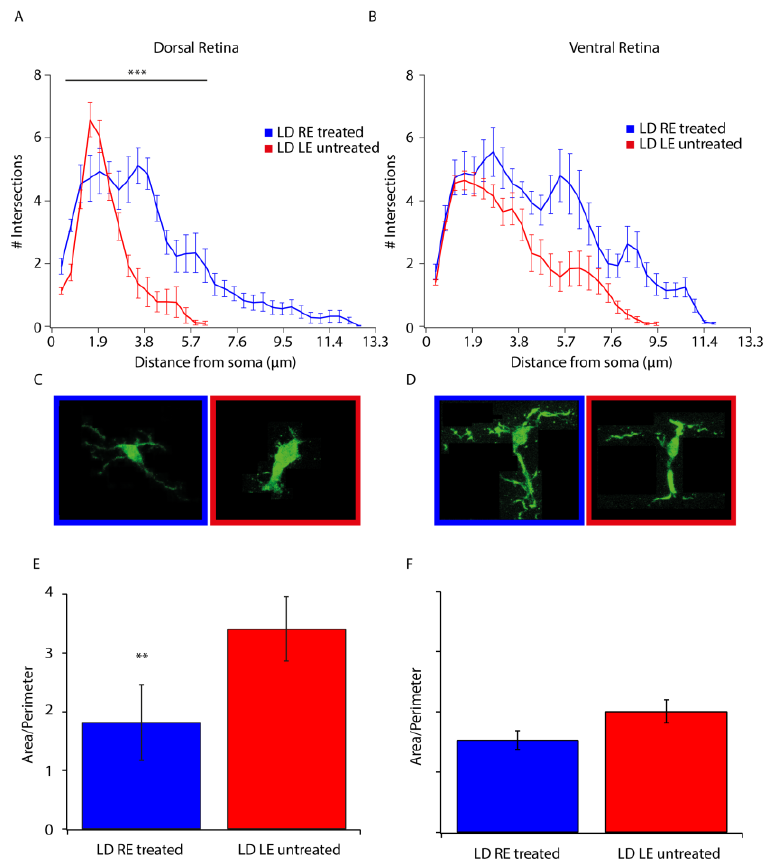
Figure 4. Microglial activation is reduced upon CBS treatment. ( A , B ) The number of intersections between microglial cell profile and concentric circles of expanding diameter (every 5 pixels corresponding to 0.38 µm) centered on the soma of the analyzed cell, in the dorsal ( A ) and ventral ( B ) retina of treated (LD RE treated, blue) and untreated (LD LE untreated, red) eyes after seven days from the light damage. ( C , D ) Representative microglial morphology in the dorsal ( C ) and ventral ( D ) retina in treated (LD RE treated, blue frame) and untreated (LD LE untreated, red frame) eyes. ( E , F ) Histograms showing the area to perimeter ratio calculated for microglial cells in the dorsal ( E ) and ventral ( F ) retina of treated (LD RE treated, blue) and Untreated (LD LE untreated, red) eyes. ** p < 0.01; *** p < 0.001.